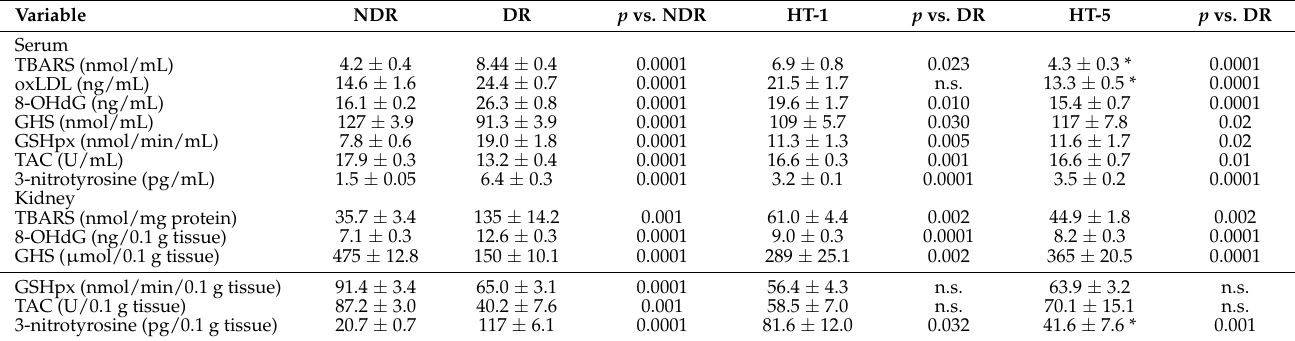
Table 2. Serum and kidney variables (mean ± standard error of the mean) of oxidative and nitrosative stress of nondiabetic rats (NDR), diabetic control rats (DR), and DR treated with hydroxytyrosol (HT) 1 mg/kg/day p.o. (HT-1) or 5 mg/kg/day p.o. (HT-5). N = 10 rats per group.